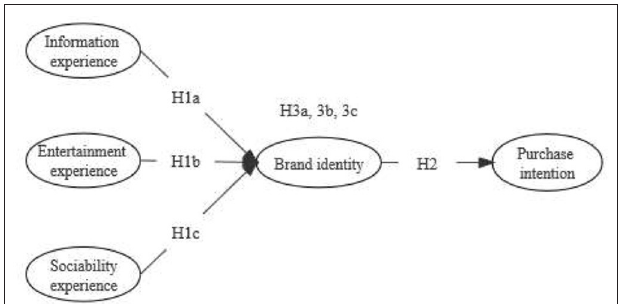
FIGURE 1 | Theoretical